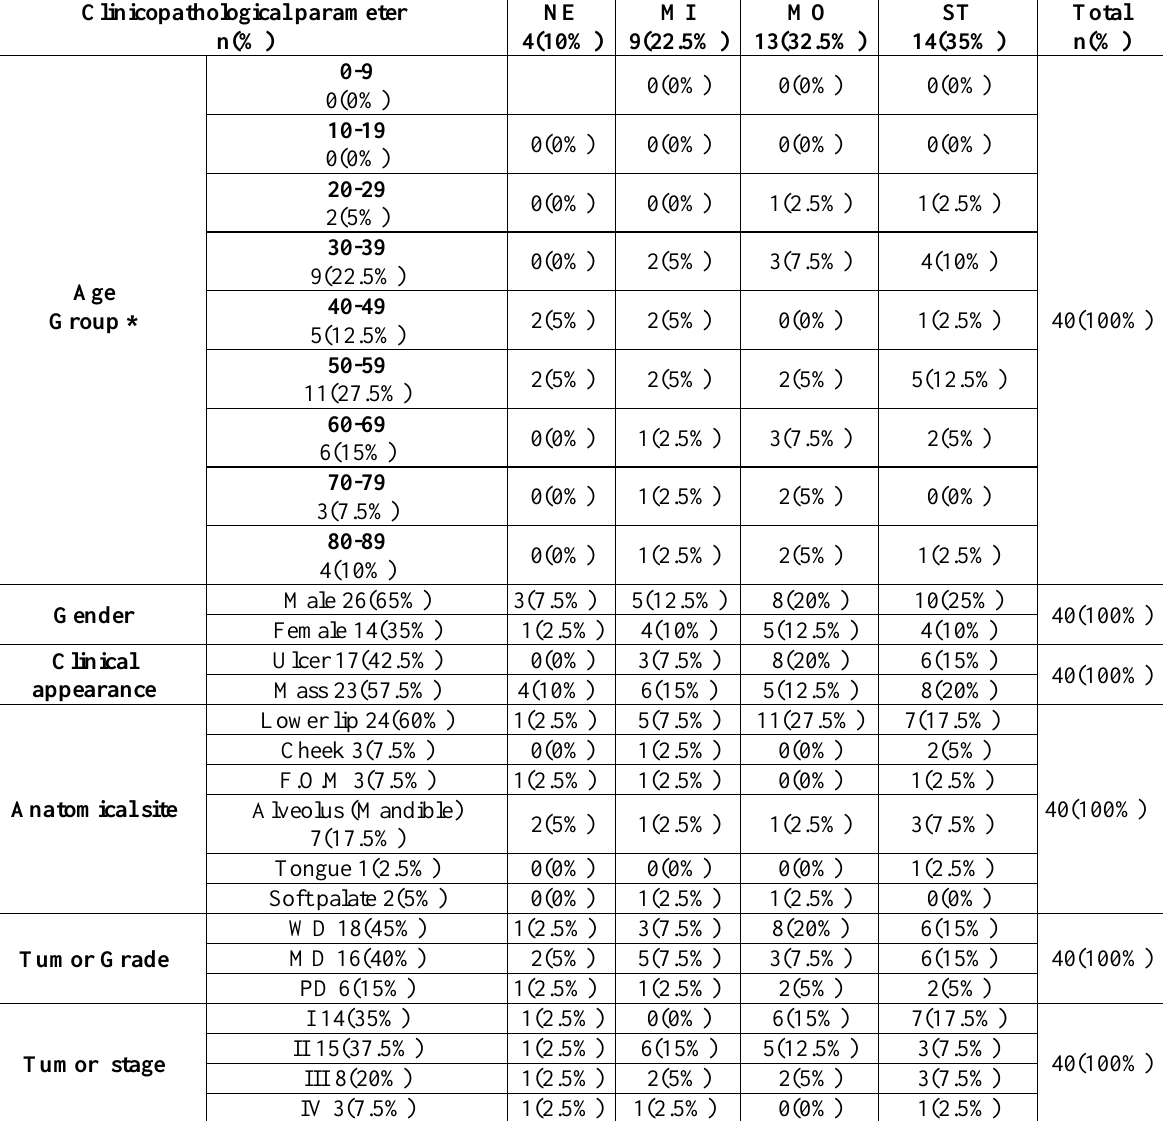
Table 3: Clinicopathological finding vs. Immunohistochemical expression of Cyclin E Clinicopathological